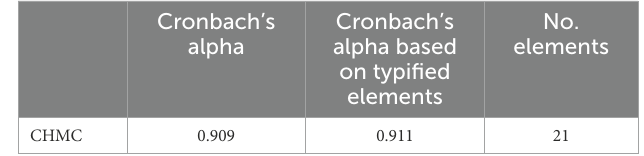
TABLE 1 The reliability coefficients of the CHMC